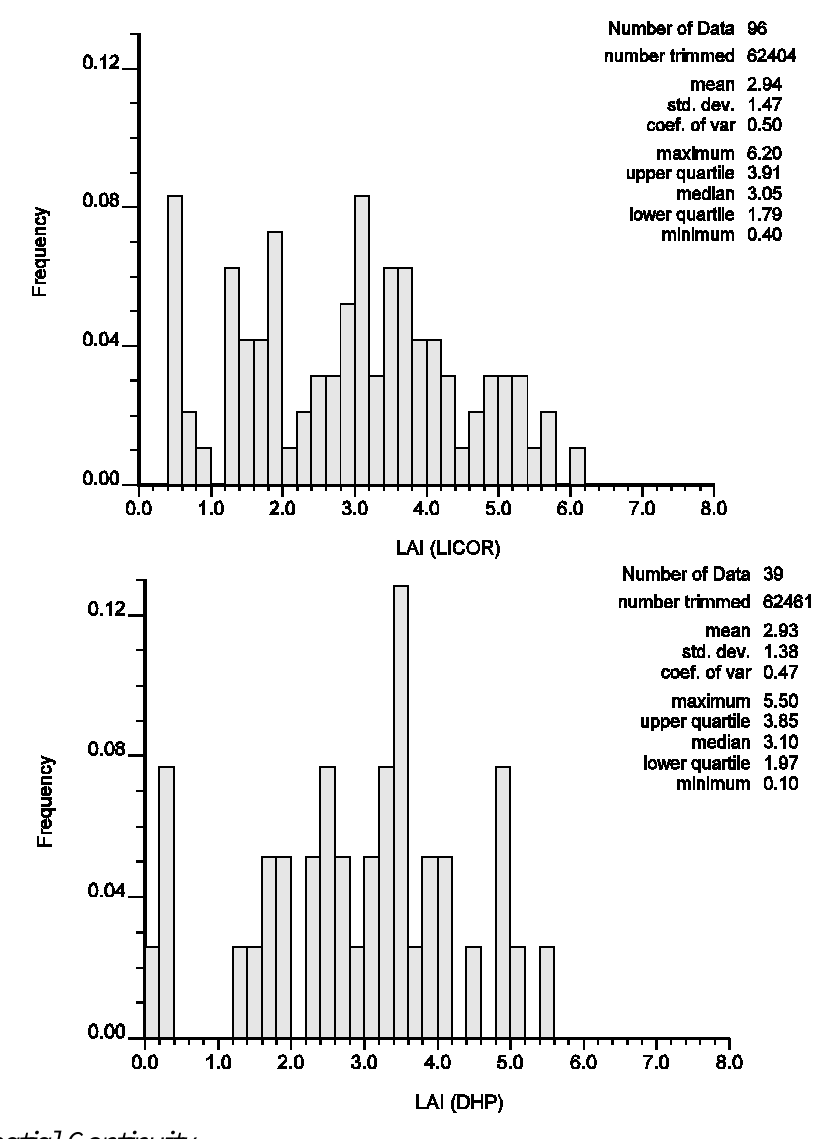
Figure 4. LAI values estimated from LICOR LAI-2000 (top) and digital hemispherical photographs (bottom) over the Barrax test